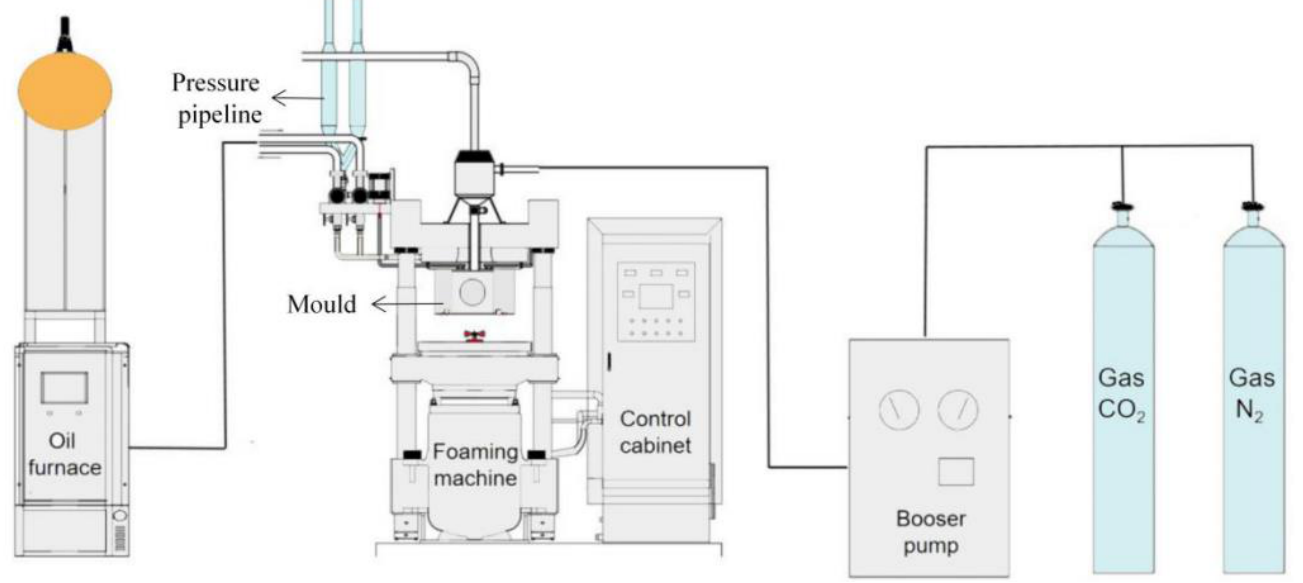
Figure 1. Diagram of supercritical molded bead foaming equipment.